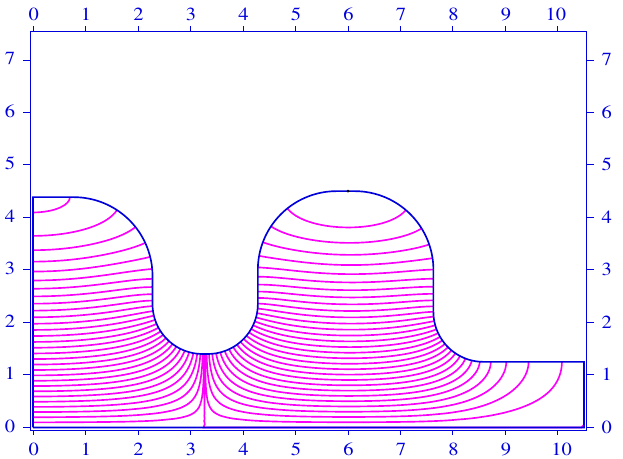
FIG. 3. Profile of the new rf gun. The iris diameter is increased to increase the mode separation.